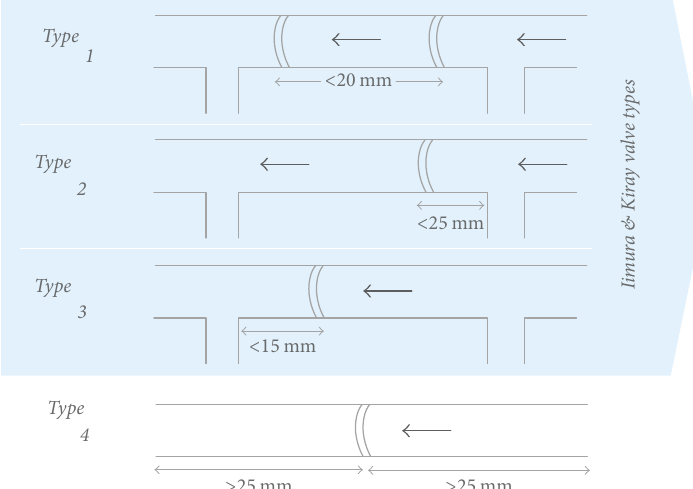
Figure 4: Modification of Kiray and Iimura’s classification system. Type 1 valve - within 20 mm of another central valve, with no intermediate branches; Type 2 valve - between two branches, closer to the peripheral branch, and within 25 mm of that peripheral branch.; Type 3 valve - between two branches, closer to the central branch, and within 15mm of that central branch; Type 4 valve was defined as having no branches or other valves within (+/ − ) 25 mm of the